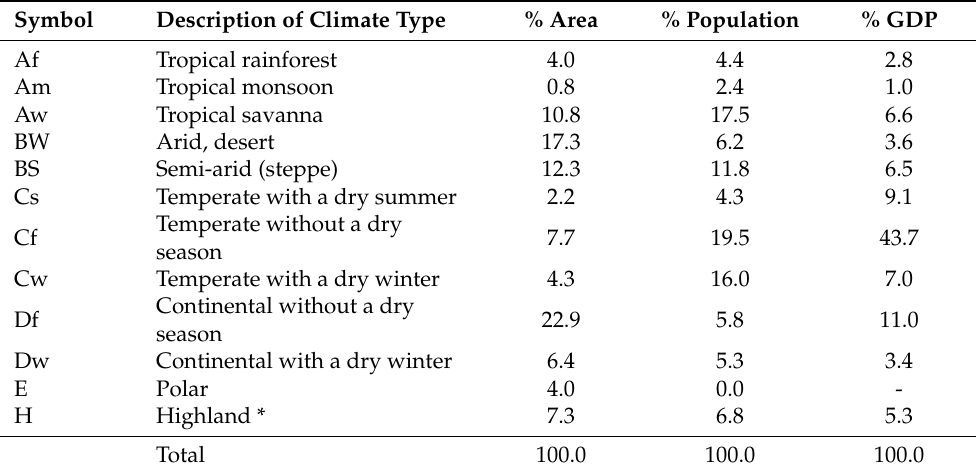
Figure 2. Updated world map of the Köppen climate classification, with the climate type groups appearing in the legend defined as: A-Tropical, B-Arid, C-Temperate, D-Cold, E-Polar (Source: [17,18]). Table 1. Distribution of land area, population and gross domestic product (GDP) by climate zone (Source: [19]).